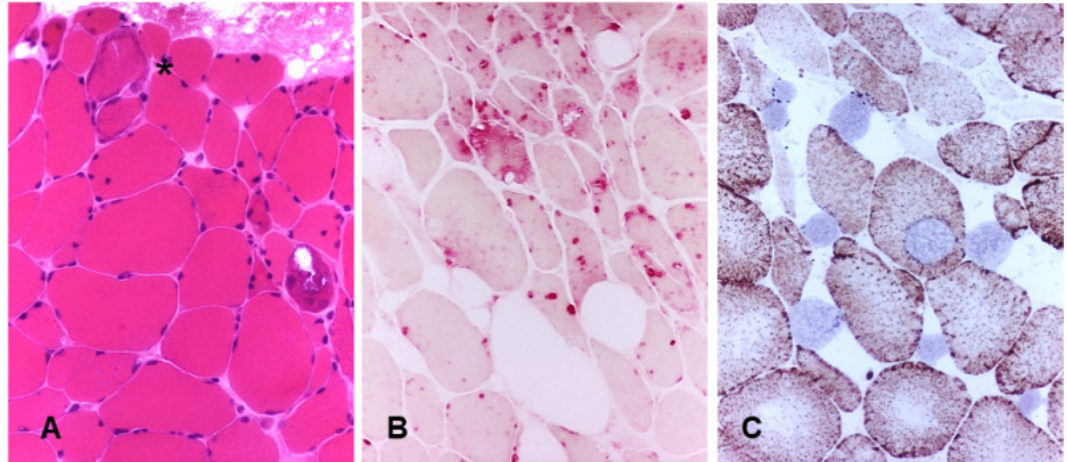
Figure 3. The muscle biopsy from a patient with late-onset Pompe disease (PD) shows myopathic changes including atrophic and hypertrophic fibers; one fiber with subsarcolemmal accumulation of mitochondria is also present (asterisk). ( A )—hematoxylin-eosin, ×20; staining for acid phosphatase highlights the increase in lysosomes in muscle fibers. ( B )—acid phosphatase, ×20; several COX-negative fibers (blue) are documented in the combined staining COX/SDH. ( C )—COX/SDH, ×20.